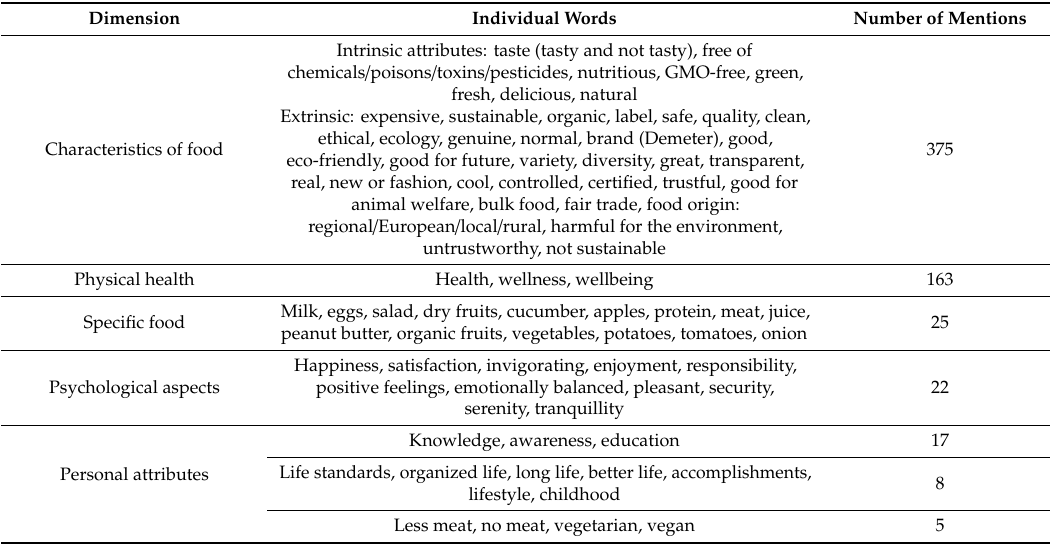
Table 8. Frequency of mention of the five dimensions of organic food-related wellbeing and the most salient individual words when participants were asked to write down the first three words that come to their mind when thinking about organic food and subjective